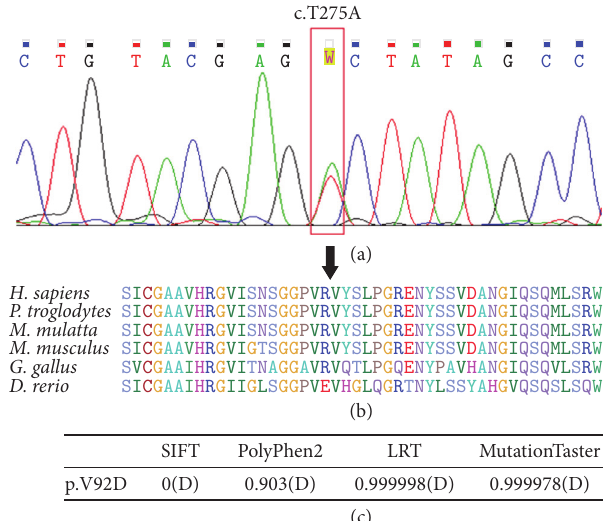
Figure 2: (a) Sanger sequencing chromatograms showing the c.T275A p.V92D mutation of the family. (b) Protein sequence alignment showing conservation of the V92 residue in cochlin across human ( H. sapiens ), chimpanzee ( P. troglodytes ), macaca ( M. mulatta ), mouse ( M. musculus ), chicken ( G. gallus ), and zebrafish ( D. rerio ). (c) Pathogenicity prediction using computational pro- grams. D in the parentheses stands for